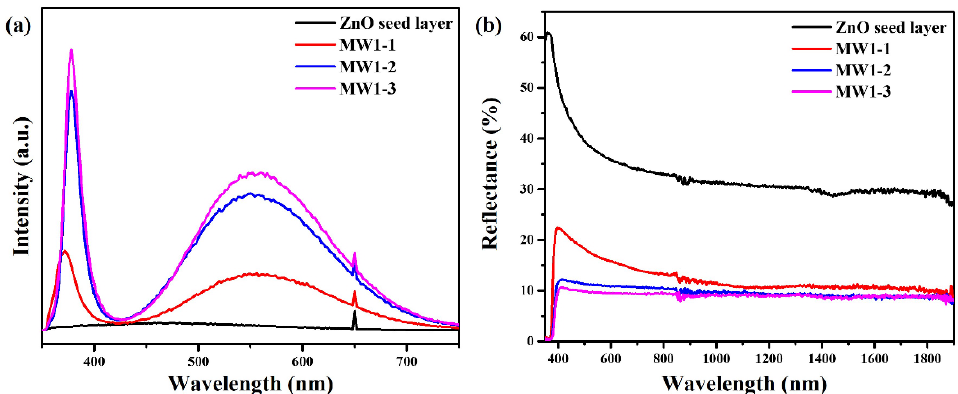
Figure 7. ( a ) PL and ( b ) reflectance spectra of ZnO nanoneedle arrays were fabricated on the silicon substrates with the ZnO seed layer at the optimized temperature programming step.